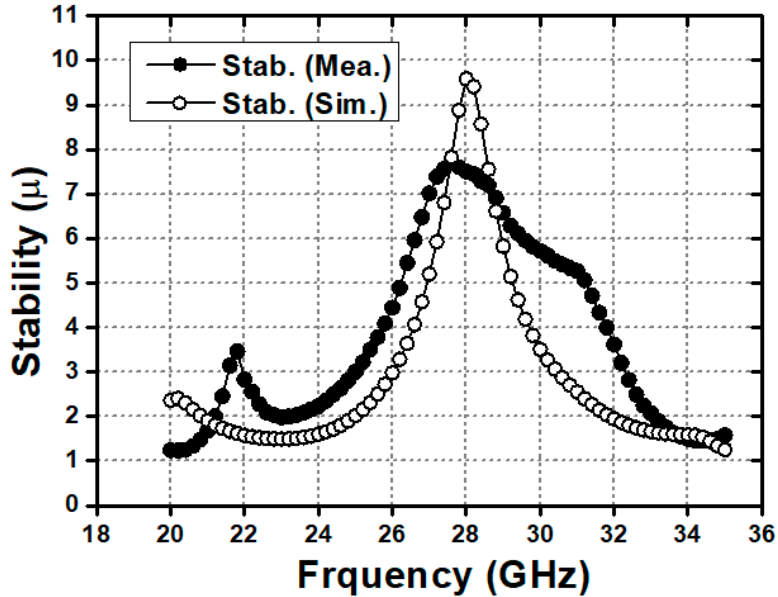
Figure 11. Measured and simulated stability μ values of the LNA.